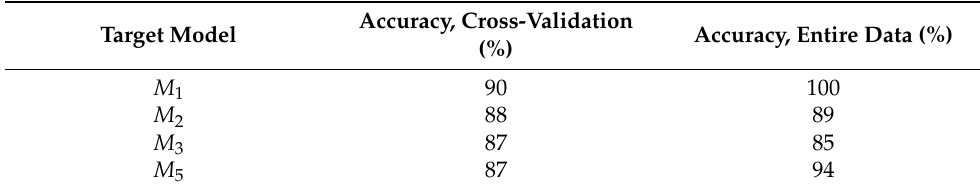
Figure 4. Confusion matrix, M 0 for DI = 80%: ( a ) M 1 , ( b ) M 2 , ( c ) M 3 , and ( d ) M 5 . Table 2. Coupled POD JDA–kernel Accuracy, DI = 80%.